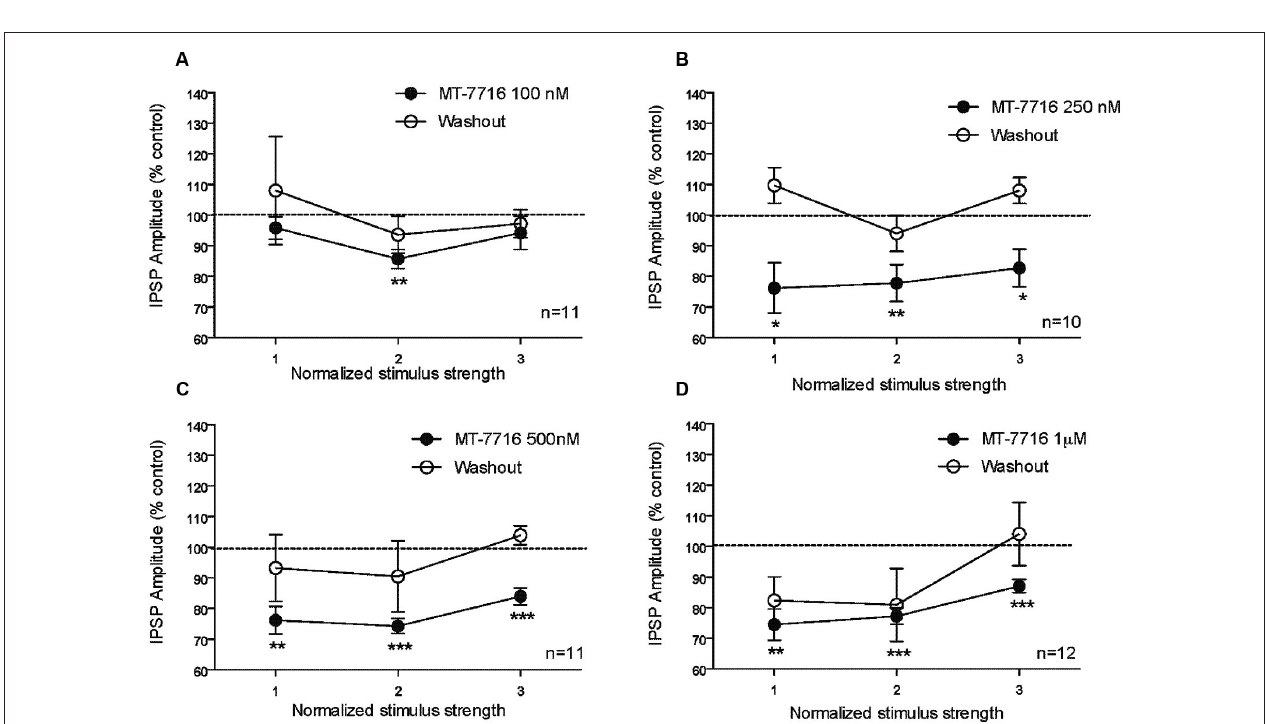
FIGURE 1 | MT-7716 decreases evoked GABAergic transmission in CeA neurons. (A) Left panel : Representative recordings of evoked IPSPs in CeA neurons from naïve rats recorded before, during, and after washout from application of MT-7716 at all the concentrations tested. (B) Right Panel : Histograms representing the percent of the peak decrease in evoked (at half